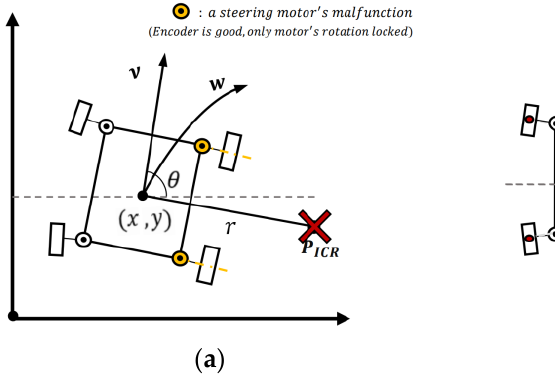
( b ) Figure 7. Slip dynamics when the right steering motor malfunctions. ( a ) Changes in the rotation center point position of each wheel due to slippage. ( b ) Change in the center point position of the robot body due to the slip of each wheel, and its recursive effect, causing further slip to occur in the four wheels.